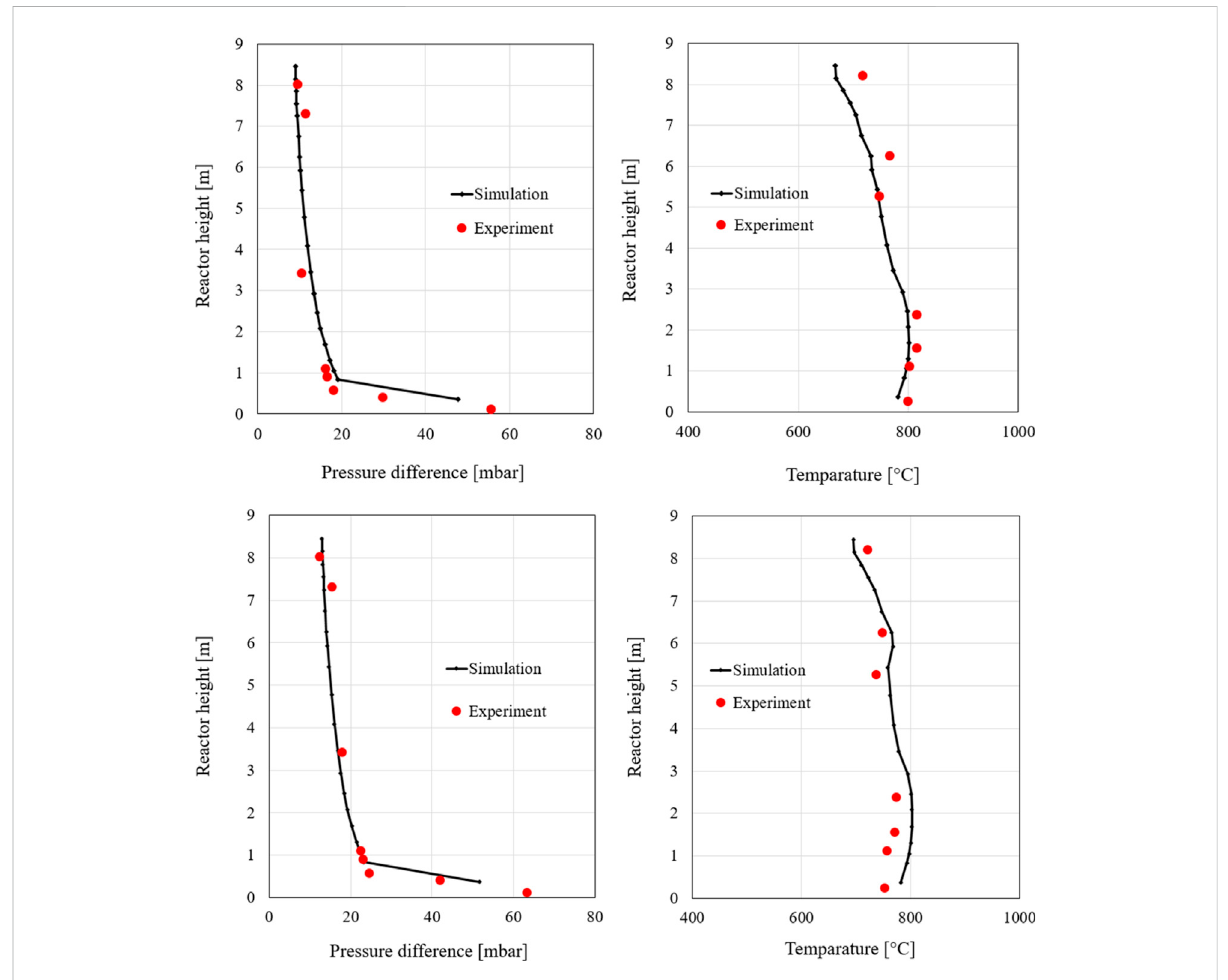
FIGURE 19 Pressure and temperature pro fi les at 16.5% and 25.1% RDF fuel mass